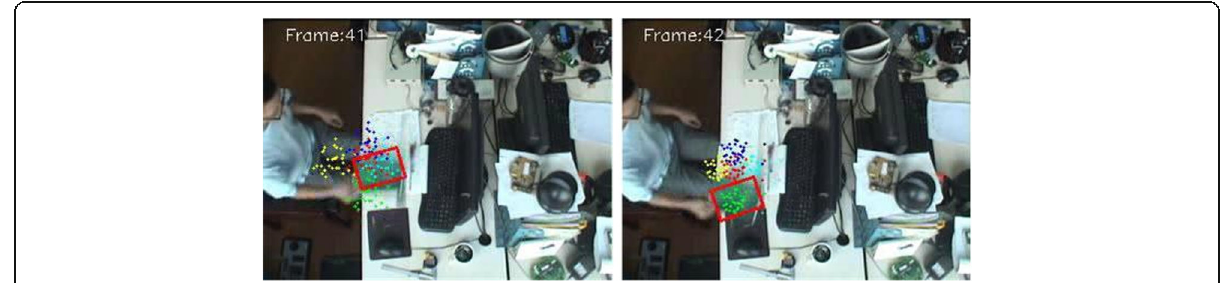
Fig. 9 Sub-particle drift